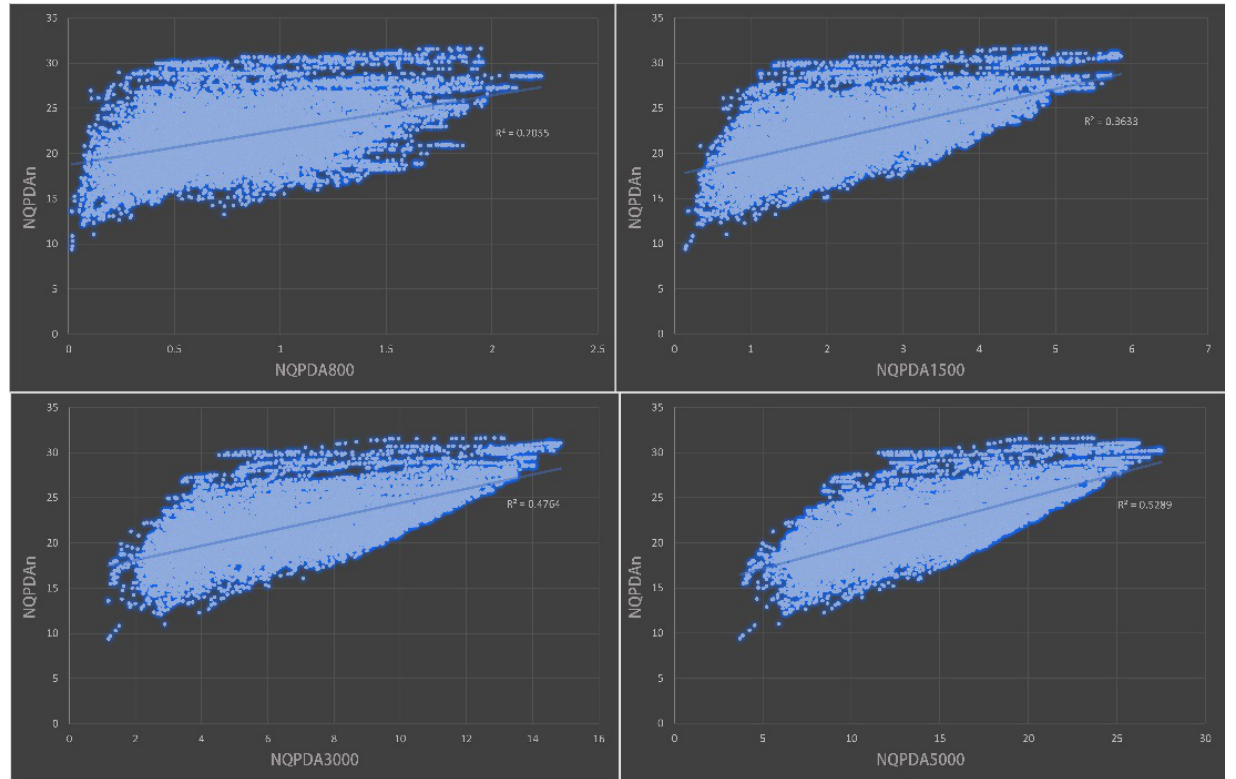
Fig. 15 Analysis of the fitting degree of